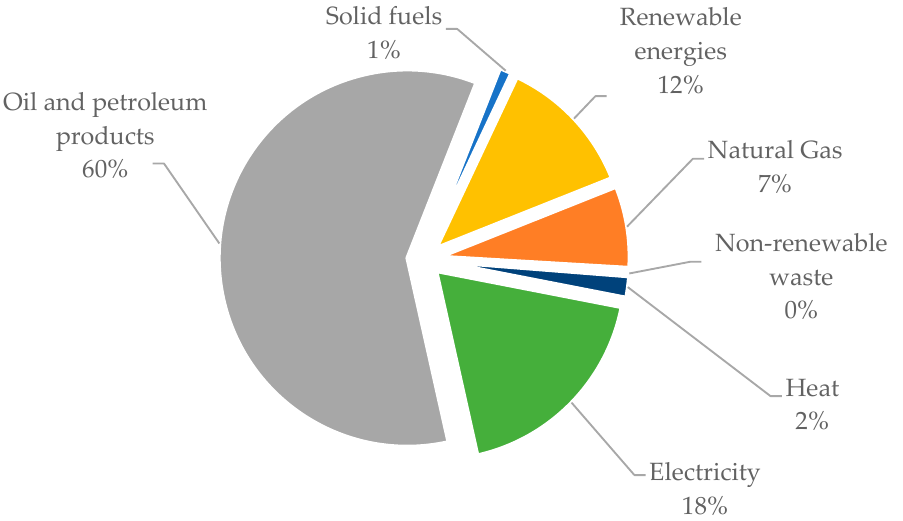
Figure 15. Portuguese energy mix available after transformation in 2019 (adopted from Eurostat data).